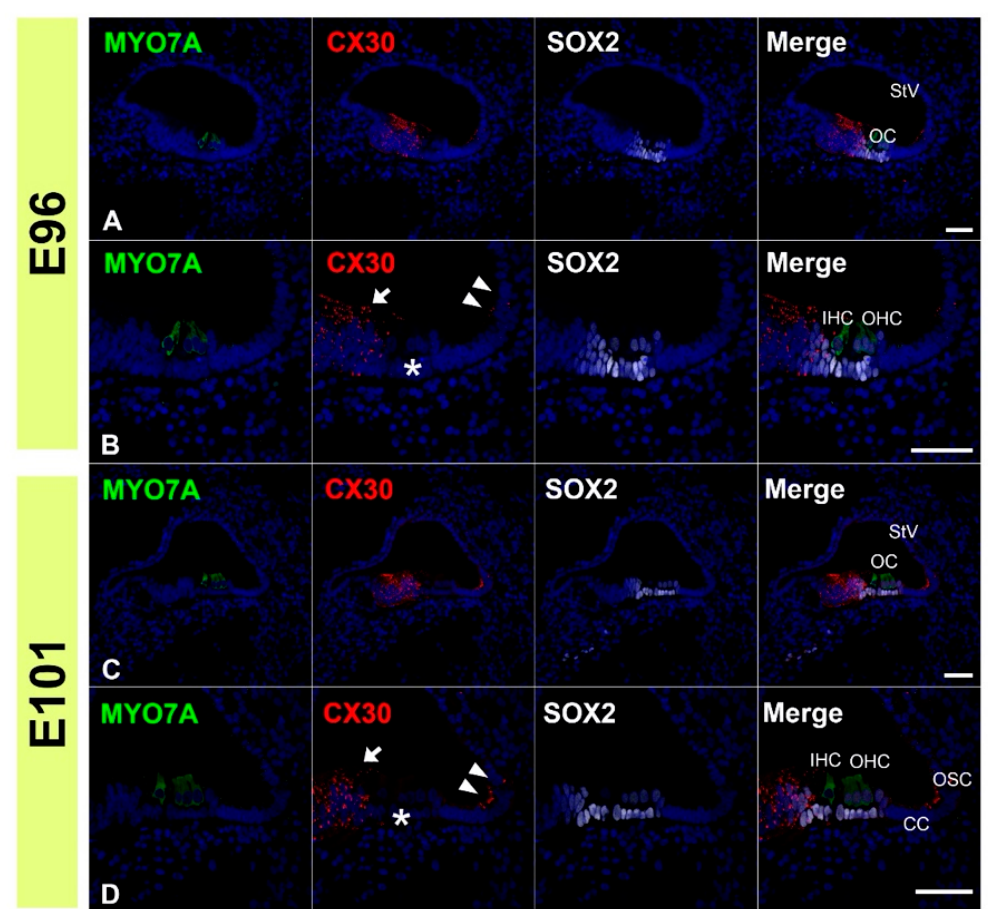
Figure 3. Changes in the expression patterns of CX30 at E96 and E101. ( A , B ) At E96, CX30 was expressed in the prosensory domain. While CX30 expression was observed in a part of the modiolus (arrow in ( B )) and lateral (arrowheads in ( B )) side of the sensory epithelium, no expression was observed around the MYO7A-positive outer hair cells (asterisk in ( B )). ( C , D ) At E101, CX30 expression was observed in the Kölliker’s organ (arrow in ( D )) and immature outer sulcus cells (arrowheads in ( D )). No expression was observed in the organ of Corti (asterisk in ( D )). SOX2 was used to label supporting cells. Nuclei were counterstained with Hoechst stain (blue). Scale bar: 50 µm in A, ( B – D ). OC: organ of Corti, IHC, inner hair cells; OHC, outer hair cells, StV: stria vascularis, CC: Claudius’ cells, OSC: outer sulcus cells. ( A – D ): basal turn.